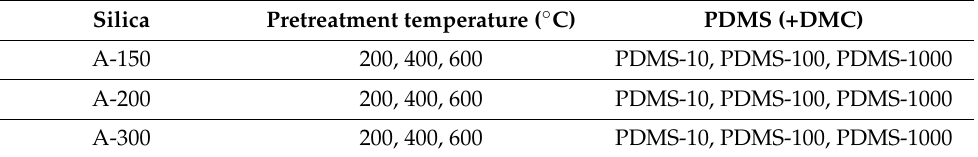
Table 1. Studied samples: pretreatment temperatures and types of modifiers. Silica Pretreatment temperature ( ◦